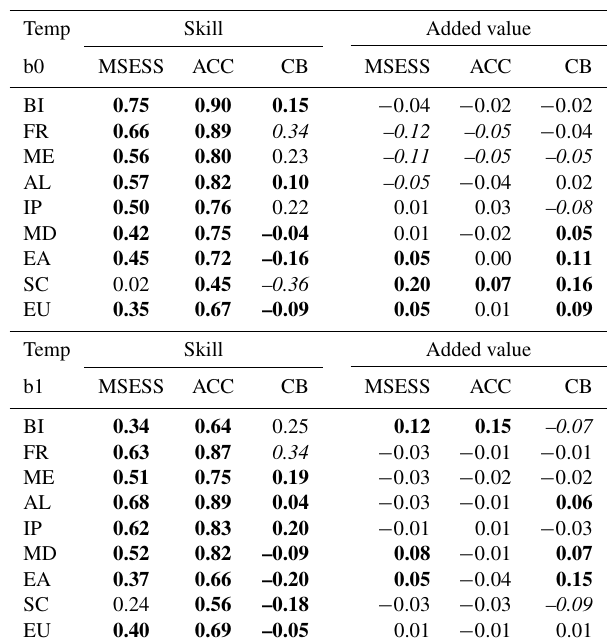
Table 1. MSESS, ACC, and conditional bias (CB) for the CCLM ensembles (left half) and added value compared to the global MPI ensembles (right half) for b0 (upper half) and b1 (lower half) for temperature averaged over the eight Prudence regions (cf. Fig. 1) and the whole of Europe (EU). In the left half, bold (italic) numbers represent MSESS values above + 0 . 3 (below − 0 . 3), ACC values above + 0 . 4 (below − 0 . 4), and CB values between ± 0 . 2 are marked in bold and beyond ± 0 . 3 in italic. In the right half, bold (italic) numbers corresponds to a distinct improvement (deterioration) by dynamical downscaling using a common threshold of ± 0.05.